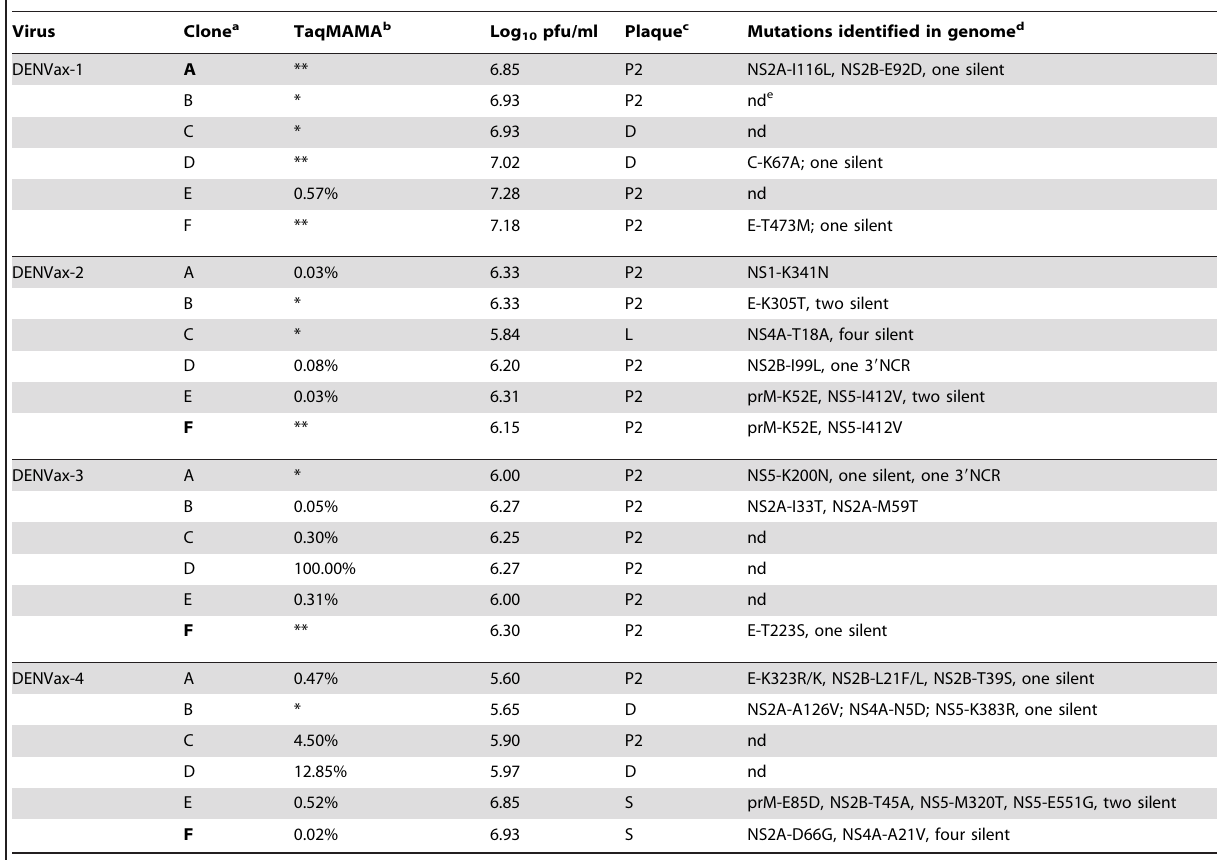
Table 2. Characterizations of pre-master (P7) seeds.